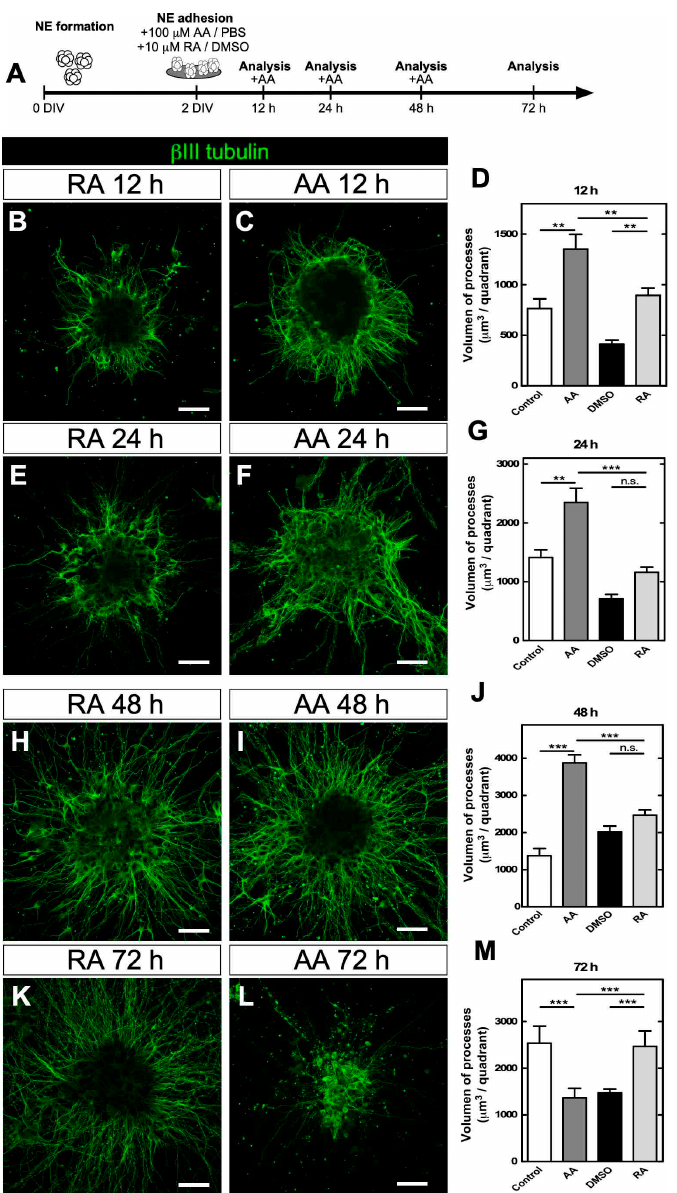
Figure 2. AA stimulated neuronal di ff erentiation in adhered NEs. ( A ) Protocol for neuronal di ff erentiation stimulated by AA or RA in adhered NEs. ( B , E , H , K ) Immunocytochemistry analysis of β III tubulin (green) in NEs treated with 10 µ M RA. Scale bar, 30 µ m. ( C , F , I , L ) Immunocytochemistry analysis of β III tubulin (green) in NEs treated with 100 µ M AA for 24 to 72 h. Scale bar, 30 µ m. ( D , G , J , M ) Neurite volume quantification. All data are representative of three separate experiments. Parametric ANOVA statistics analysis, Tukey posttest, ** p < 0.01; *** p < 0.001; n.s., not